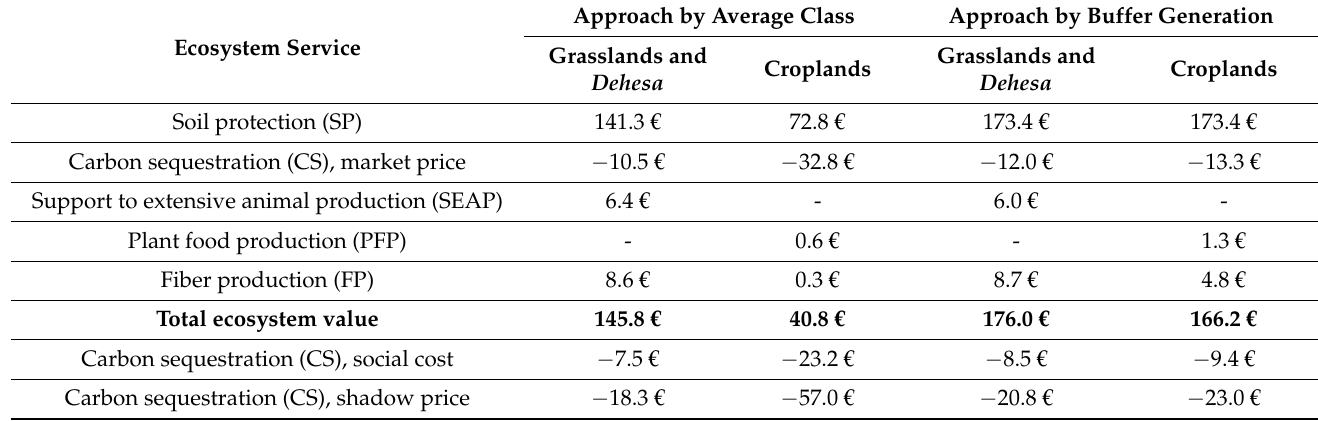
Table 5. Total Ecosystem Value (in euros— € /ha/year) per considered ecosystem.